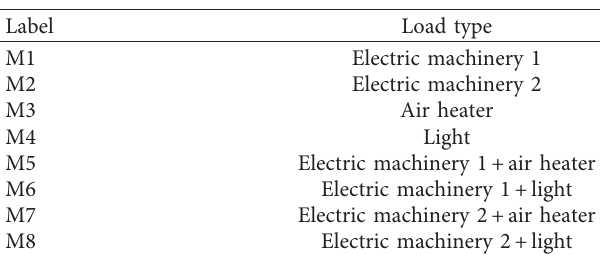
Table 1: Load type.